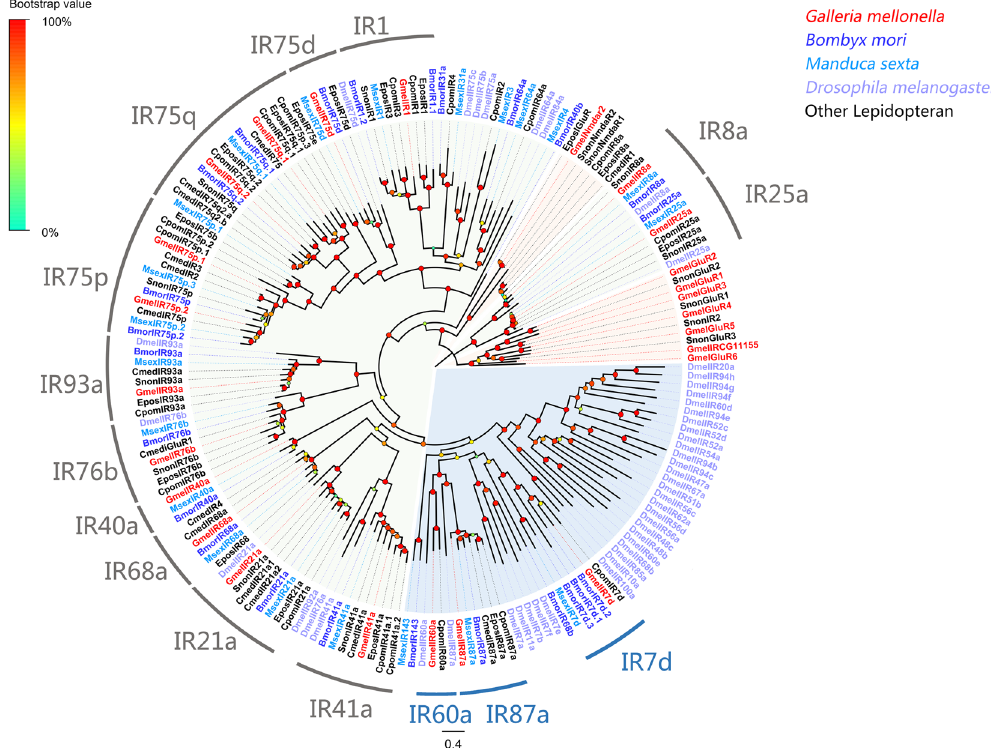
Figure 2. Maximum-likelihood tree of iGluRs/IRs. The distance tree was rooted by the conservative IR25a/ IR8a gene orthologous. Species abbreviations: Gmel, Galleria mellonella ; Bmor, Bombyx mori ; Cmed, Cnaphalocrocis medinalis ; Cpom, Cydia pomonella ; Epos, Epiphyas postvittana ; Msex, Manduca sexta ; Snon, Sesamia nonagrioides ; Dmel, Drosophila melanogaster . Highlighted clades: non-N-Methyl-D-aspartic acid (purple), iGluRs (orange), antennal IRs (green) and divergent IRs (blue). Node support (circles at the branch nodes) was estimated using an approximate likelihood ratio test based on the scale indicated at the top left. Bars indicate branch lengths in proportion to amino acid substitutions per site.